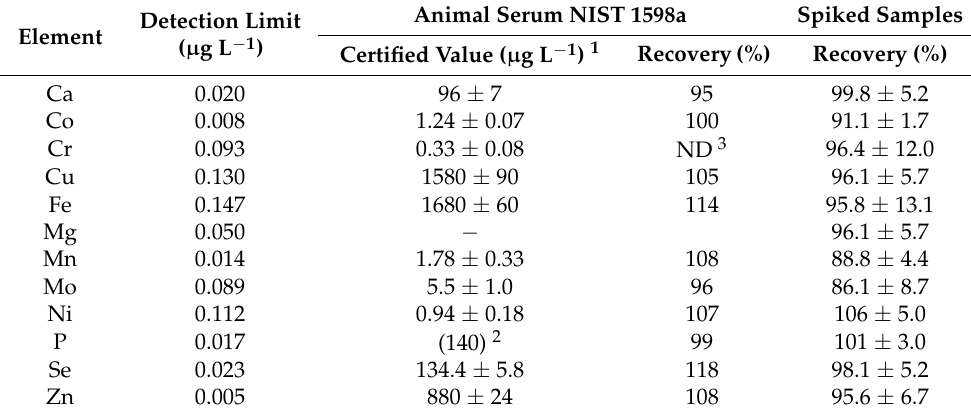
Table 2. Results of the analytical quality control